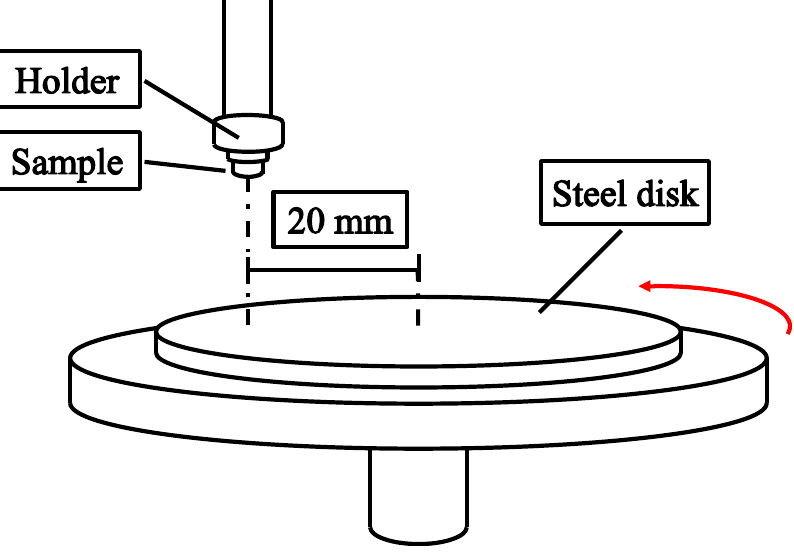
Figure 1. Schematic diagram of the pin-on-disk test to determine the adhesive